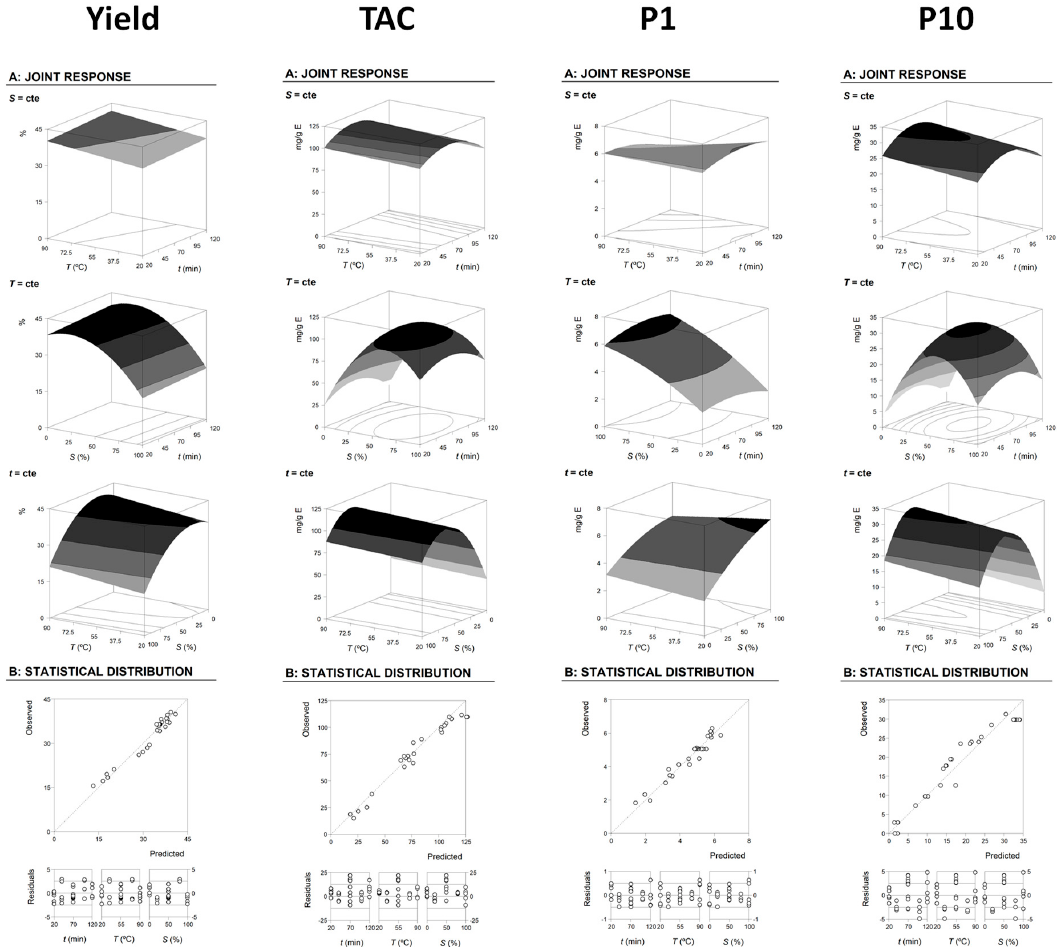
Figure 3. Illustrative representation of the extraction yield and grouped anthocyanin compounds (total anthocyanin acids, total flavonoids and total anthocyanin compounds) responses. The part A shows the 3D description as a function of each independent variable. The surfaces were constructed using the values presented in Table 3 and described by Equation (1). In each graph, the excluded variable was positioned at the optimum of their experimental domain (Table 3). Part B shows a summary of the goodness of fit using the observed/predicted and the residual distribution plots as a function of each variable.